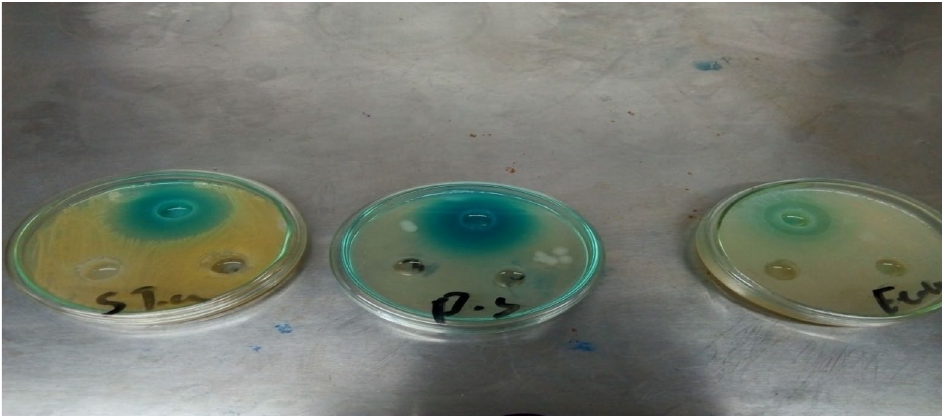
Fig. 24 Microbial toxicity assay showing effect of the untreated and treated dye solution on